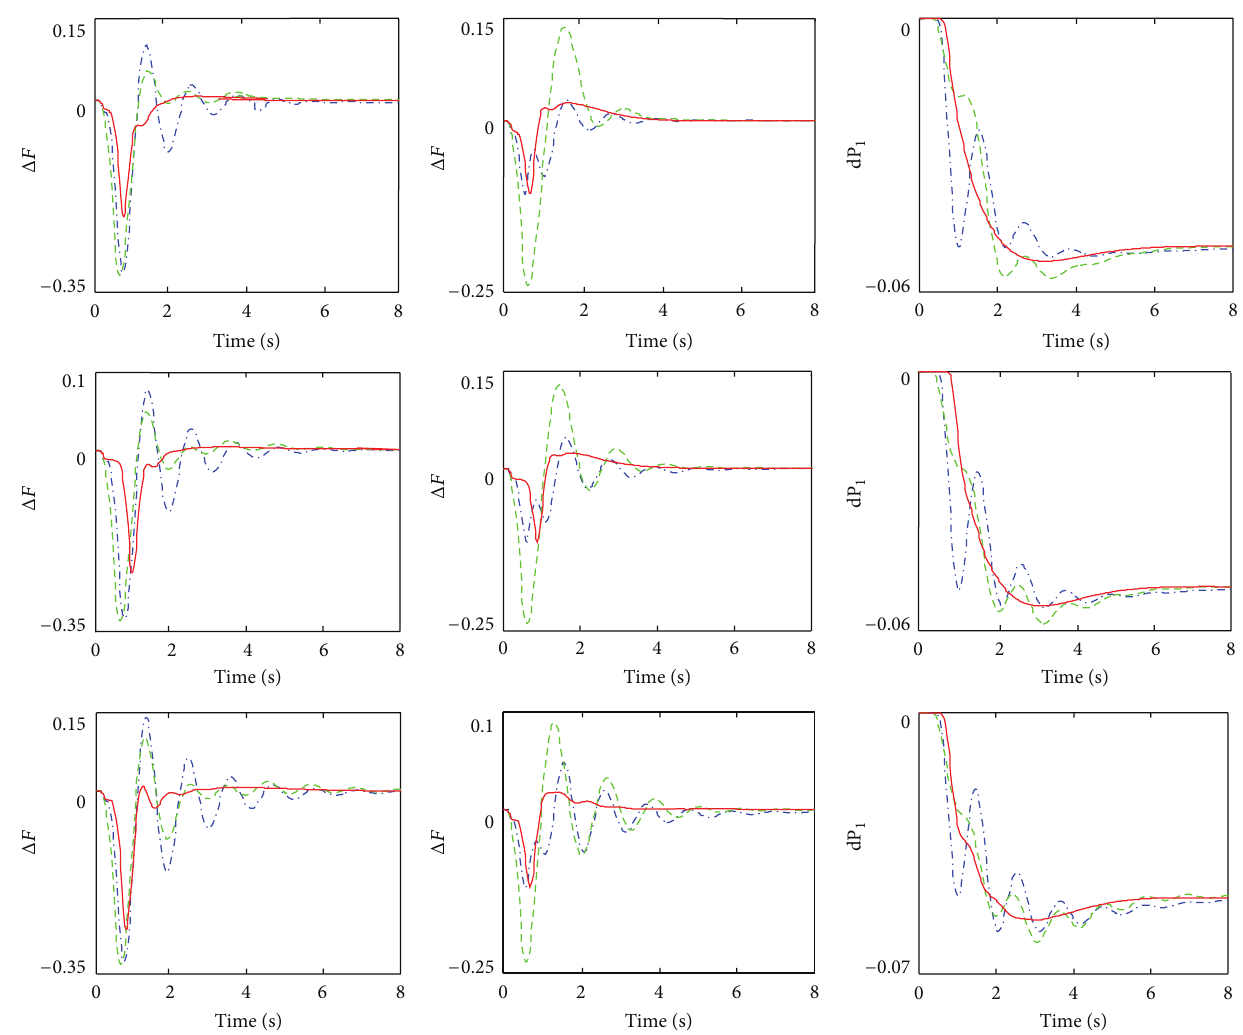
Figure 5: Deviation of frequency and tie-line power flows; solid (IABC-F), dashed (PSO-F), and dashed dotted (GA-F).